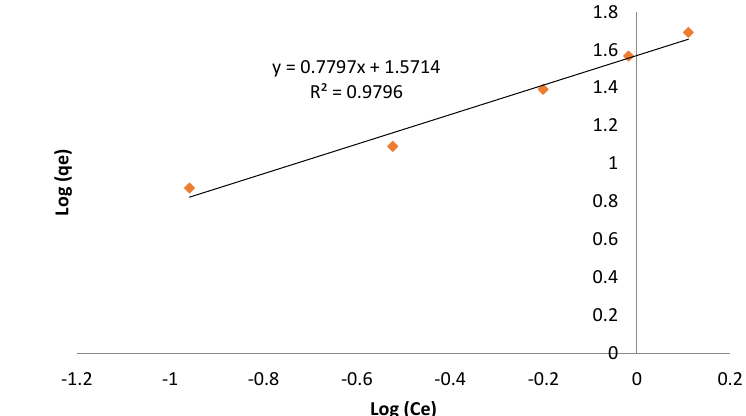
Figure 10. Freundlich isotherm of adsorption of methyl orange by the adsorbent